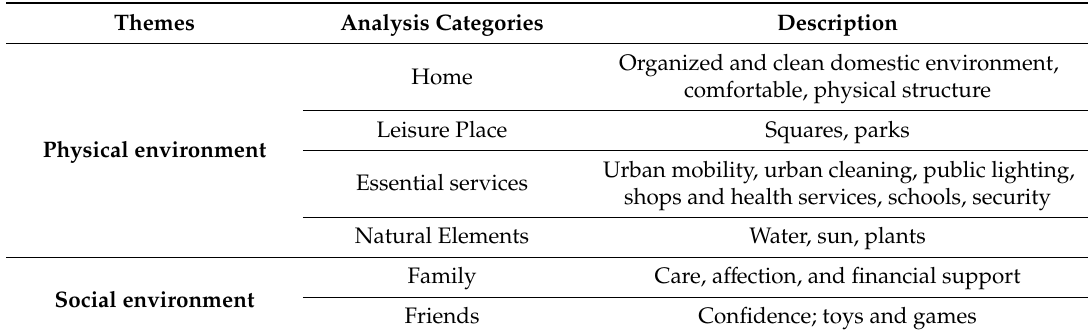
Table 2. Description of the themes and categories observed in the drawings with narrative, about Quality of Life (QoL) in their living neighborhood, 6–10 years old,